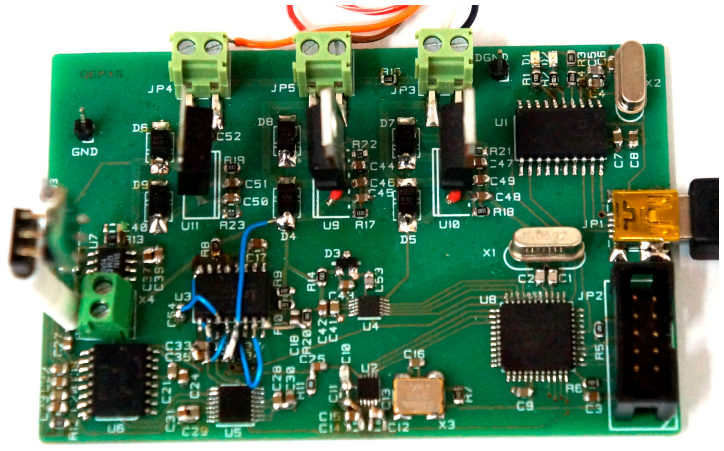
Figure 5. A photo of the designed system during QTF measurements.